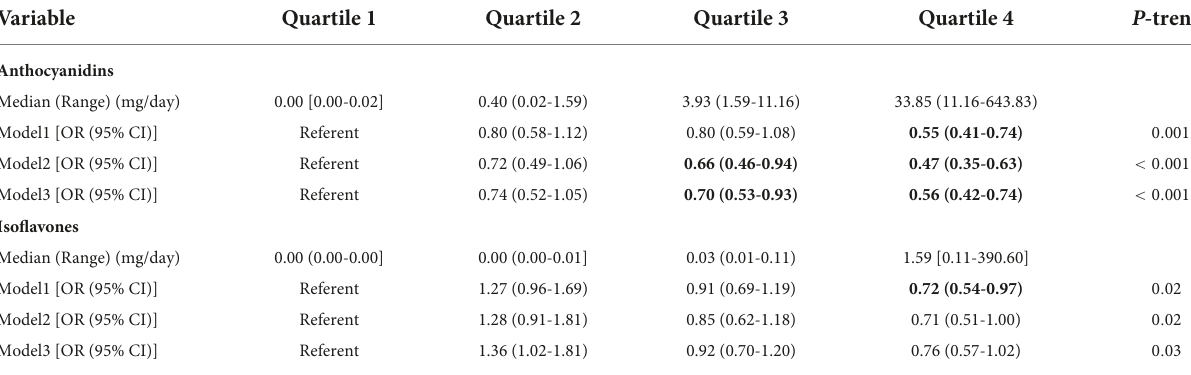
TABLE 3 The multivariate logistic regression analysis results of association between anthocyanidin or isoflavone intake with the risk of metabolic associated fatty liver disease (MAFLD) prevalence, weighted. Variable